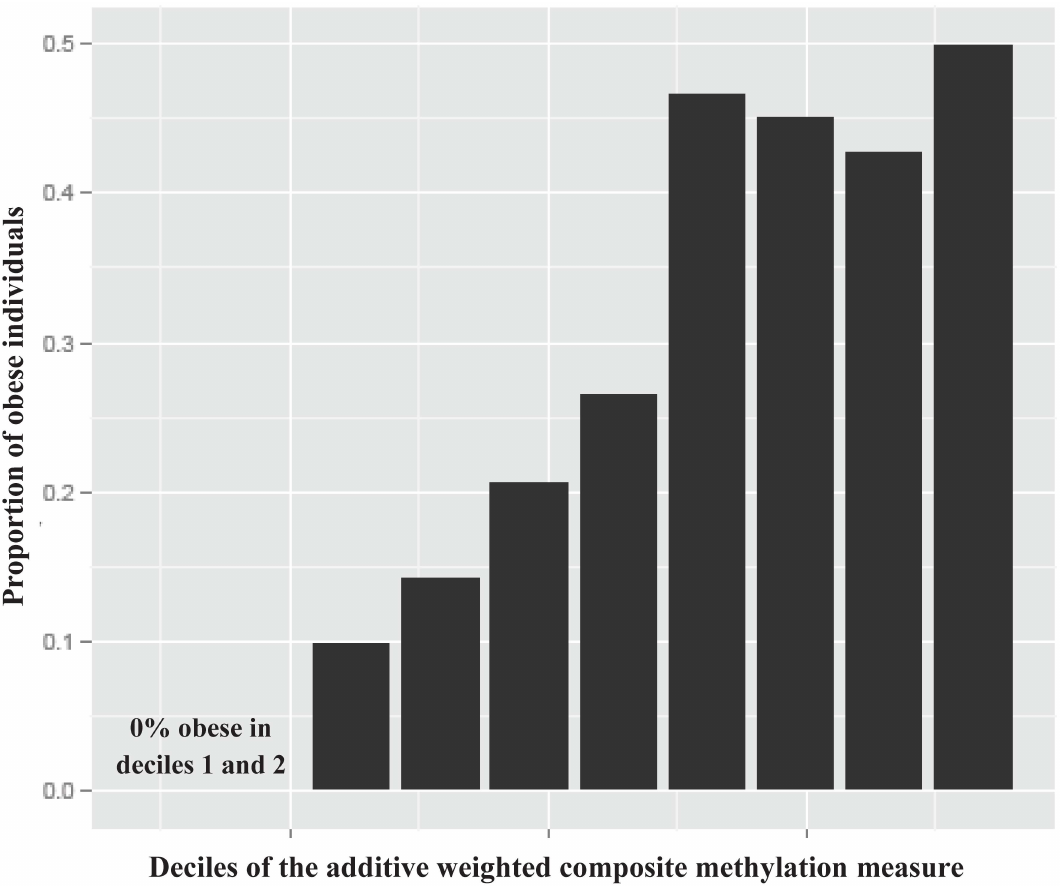
Fig 2. Histogram of the proportion of obese individuals (BMI (cid:21) 30 kg/m 2 ) in the PIVUS cohort across deciles of the additive weighted composite methylation measureof the 77 nonredundant replicated CpGs (| r | < 0.7) from the BMI epigenome-wide association study. BMI, body mass index; PIVUS, Prospective Investigation of the Vasculature in UppsalaSeniors. (S7 Table). There were significant three-way associations (CpG versus BMI; CpG versus gene expression; gene expression versus BMI) for 11 CpGs with seven unique annotated genes (Table 4). Five of the seven genes (71%) with significant three-way associations between CpG– gene expression–BMI are known to exhibit cardiometabolic phenotypes in murine gene knockout models [37–44].